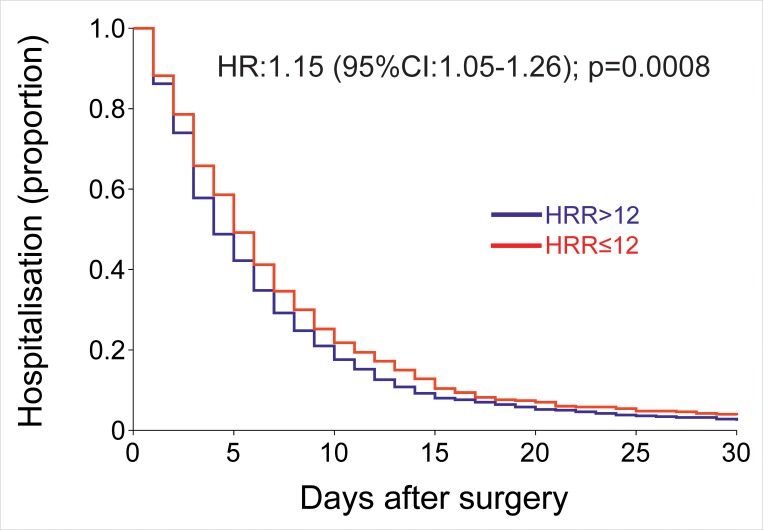
Delayed heart rate and postoperative outcome.Unadjusted Kaplan-Meier estimator for all surgery types showed that delayed heart rate recovery was associated with prolonged hospital stay (HR: 1.15 (95%CI:1.05–1.26); p = 0.0008).